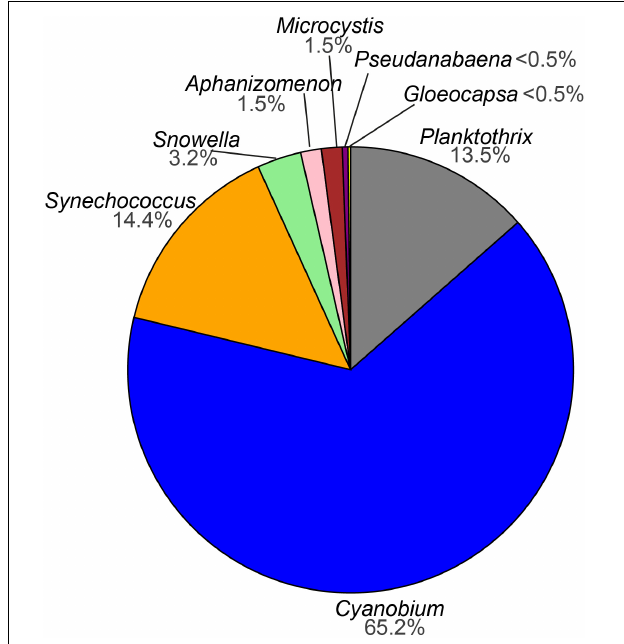
FIGURE 3 | Pie chart showing the percentage of amplicon sequence variants (ASVs) assigned to cyanobacteria ( > 0.1% relative abundance) from this